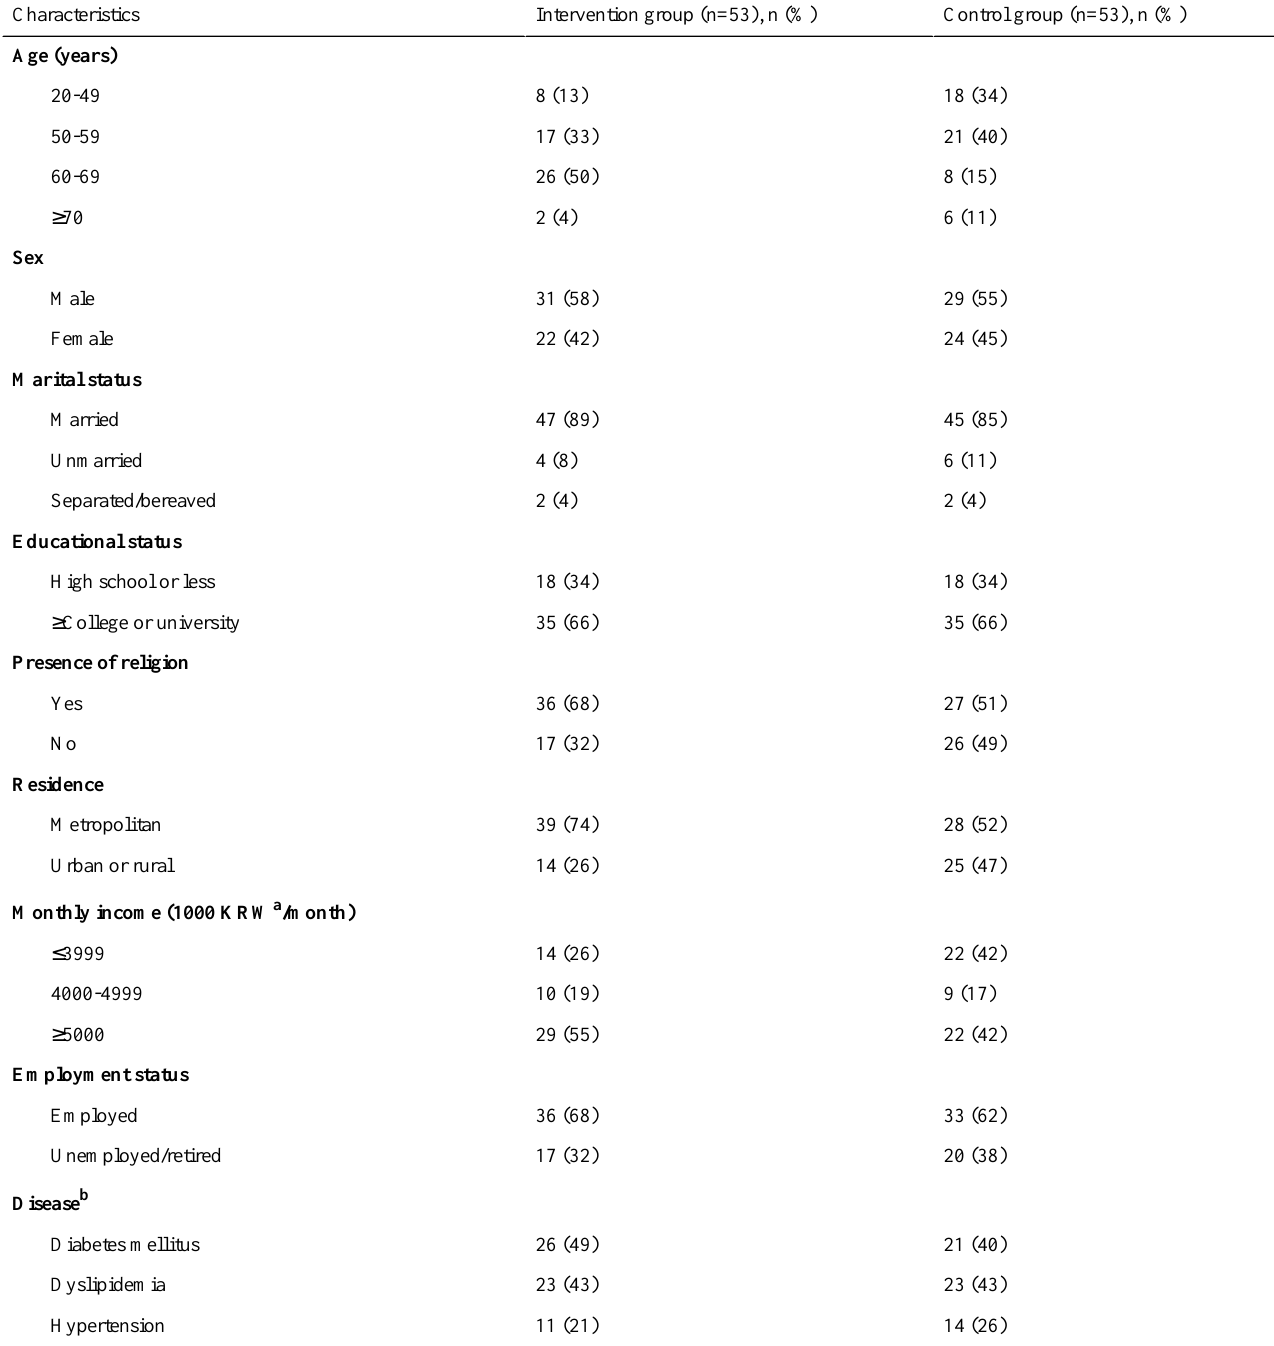
Table 1. Baseline characteristics of